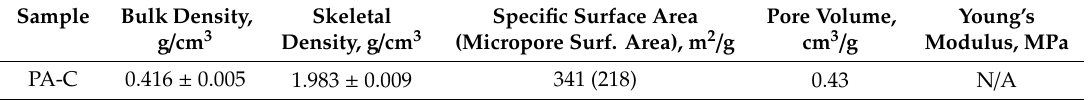
Table 3. Measured characteristics of the PA-C sample.